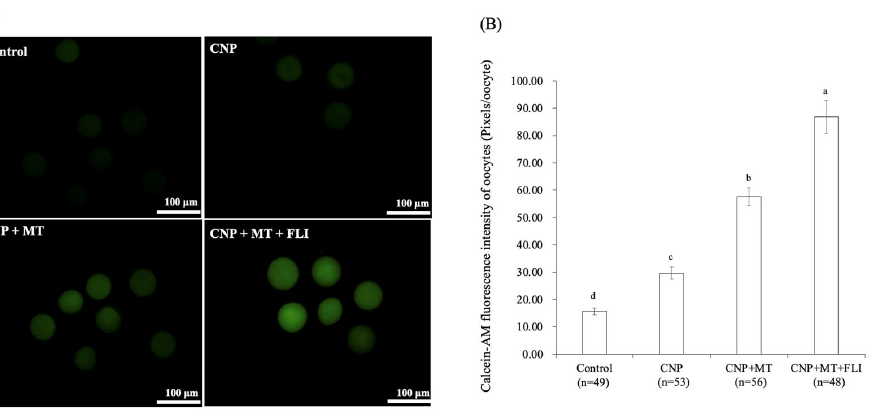
Figure 5. Effect of the combination treatment CNP, MT, and FLI on calcein-AM fluorescence intensity of bovine oocytes. ( A ) Representative image staining of calcein-AM in bovine oocytes. Bar = 100 µ m. ( B ) Effect of CNP+MT+FLI on the calcein-AM fluorescence intensity of bovine oocytes. a, b, c, d Values with different superscripts indicate significant differences between groups ( p < 0.05).